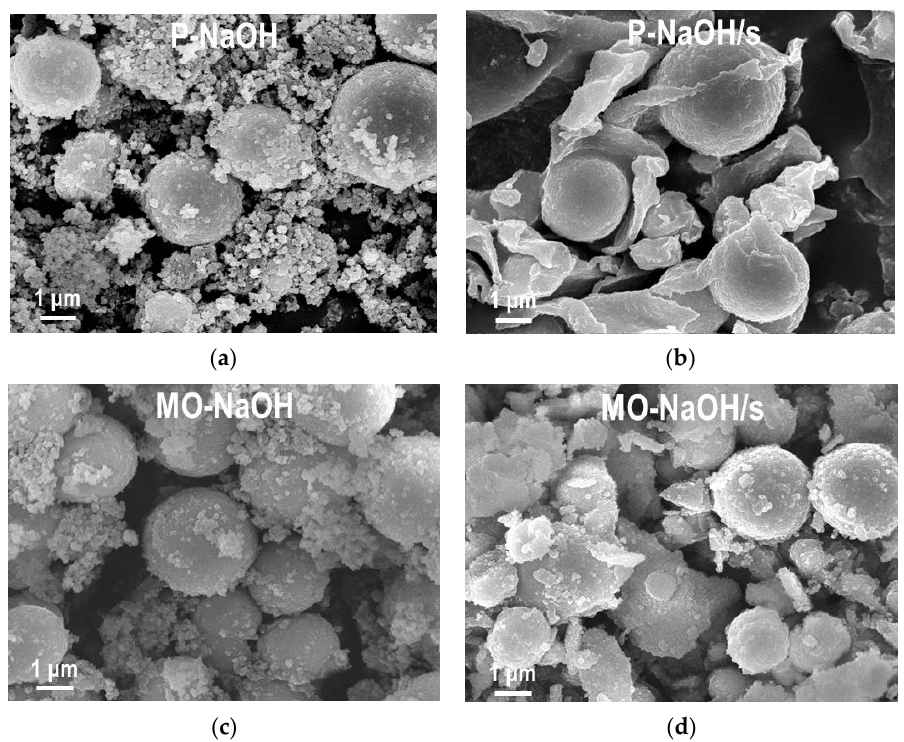
Figure 2. SEM images of precursors and calcined mixed-oxide materials obtained with NaOH precipitant, without or with starch: ( a ) P-NaOH; ( b ) P-NaOH/s; ( c ) MO-NaOH; ( d ) MO-NaOH/s. Magnification × 10,000.